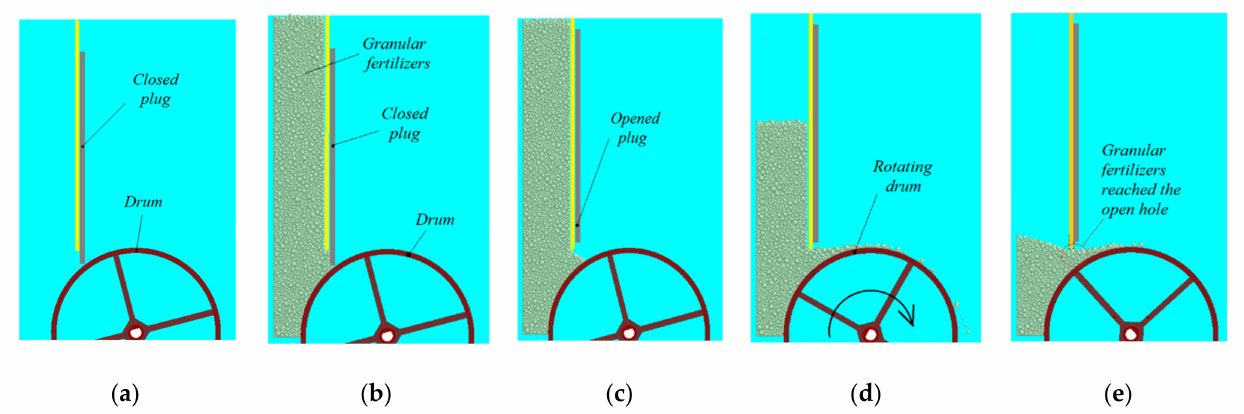
Figure 9. Discharge process of the discharge-drop test: ( a ) Free container; ( b ) filled container; ( c ) opened plug; ( d ) particle discharge due to drum rotation; ( e ) discharged particles reached the open hole.